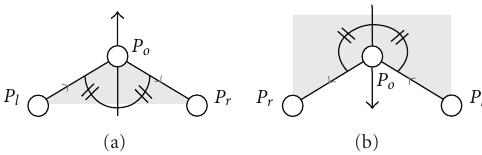
Figure 1: Front tracking and markers. Circles represent markers along the firefront line. Arrows show the propagation vector (bisec- tor of the local angle at the marker P 0 between the point at left, P l , and point at right, P r ). Grey area represents the burned fuel.